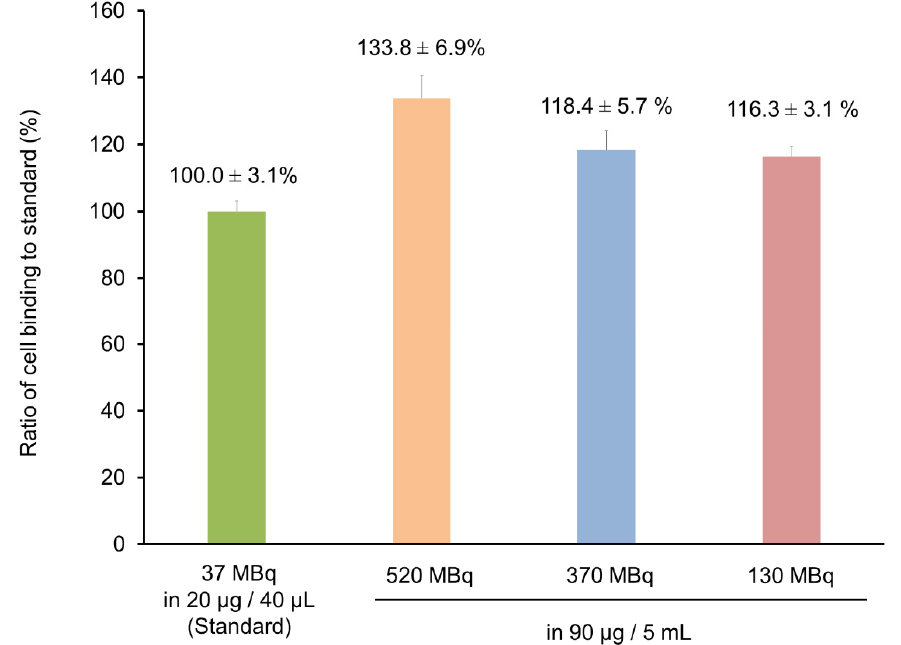
Figure 6. Cell binding of 64 Cu-NCAB001 prepared at clinically feasible radioactivity concentrations. PCTA-NCAB001 dissolved in Solution C (composition in Table 1) and stored at 4 ◦ C for 12 months was radiolabeled with 64 Cu, and cell-binding assays were performed. Cell binding of 64 Cu-NCAB001 at clinically feasible radioactivity concentrations up to 520 MBq for 90 µ g of PCTA-NCAB001 in 5 mL was evaluated using the experimental preparation with 37 MBq for 20 µ g of PCTA-NCAB001 in 40 µ L as a reference standard.